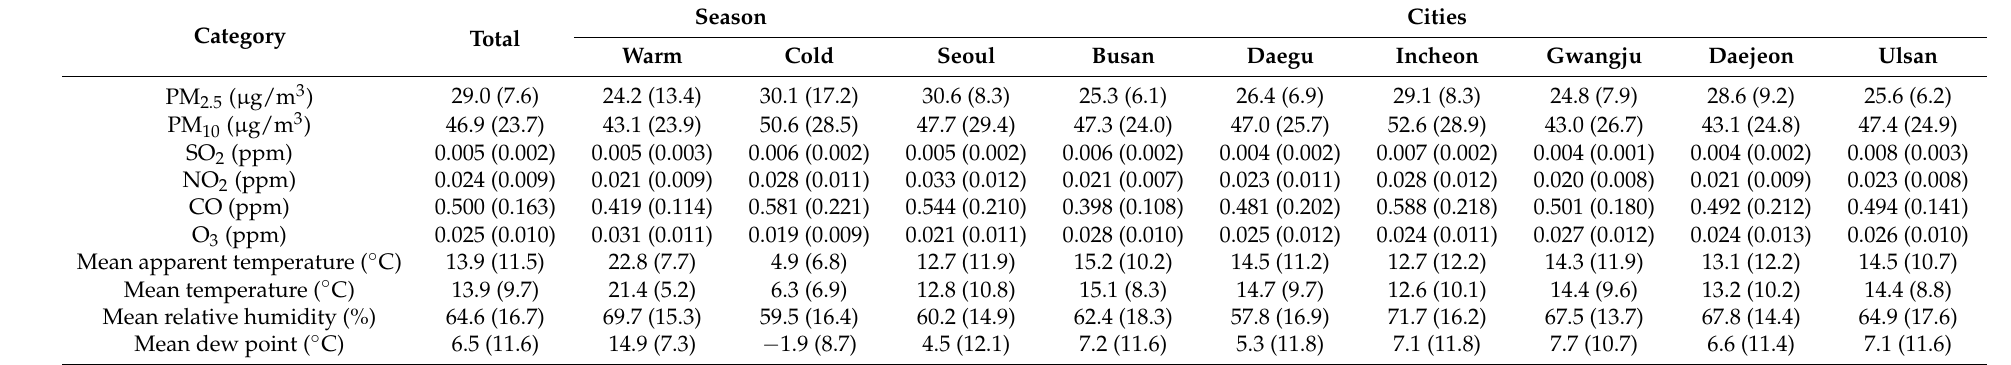
Table 2. Descriptive statistics for daily air pollutants and environmental variables in seven metropolitan cities in Korea, 2008–2016. The warm season is April–September and the cold season is January–March,